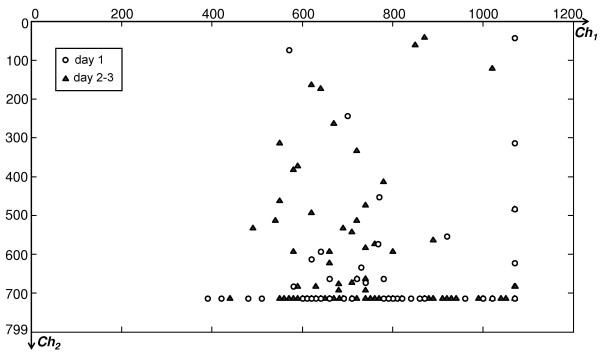
Control signal values corresponding to the reaching of stable precision grasps. Precision grasp points distribution over the Ch1,Ch2 plane for all subjects in G2. Circles denote grasps on the first day, triangles correspond to grasps on day 2 and day 3.